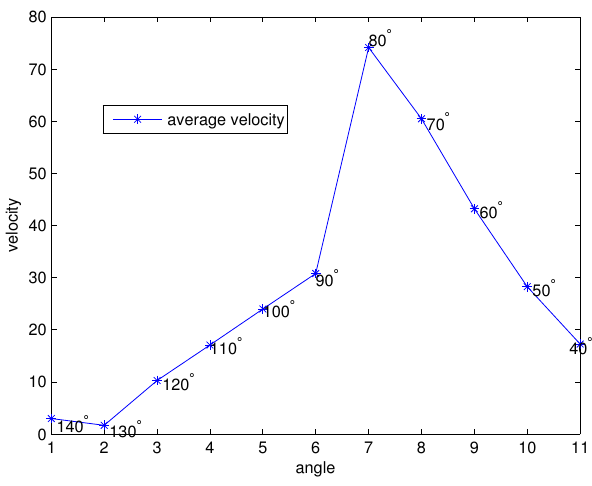
Figure 9. The average velocities for each angle θ .